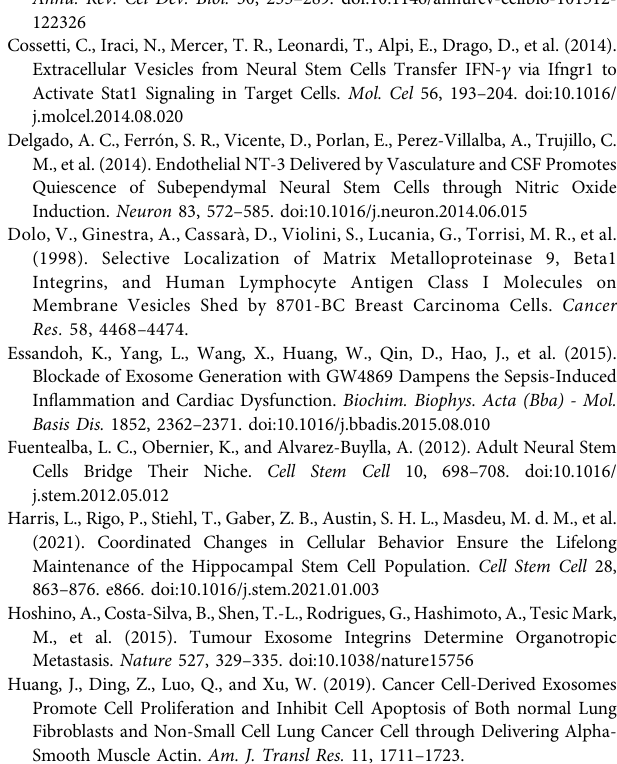
Supplementary Table S3 | Gene ontology analysis of enriched proteomes. Supplementary Table S4 | Gene ontology annotation